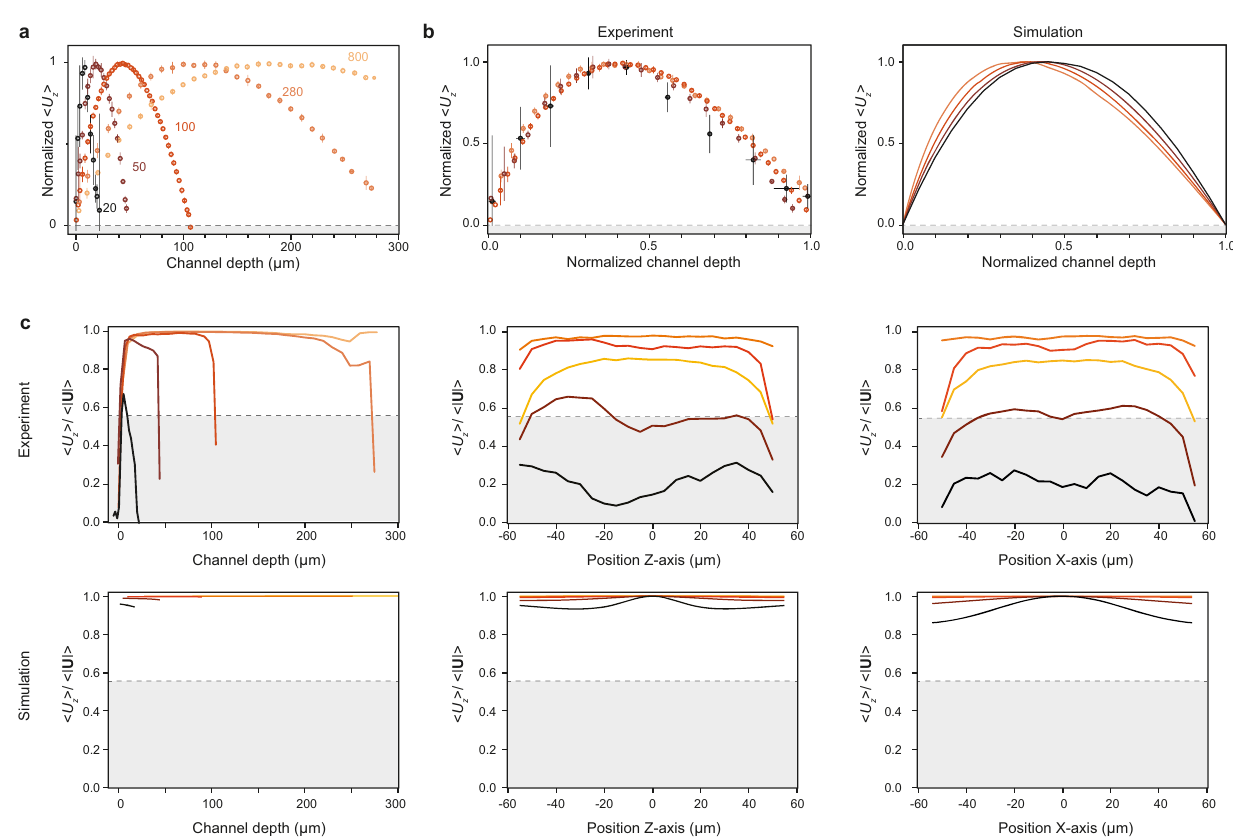
Fig. 4 Presence of convection-driven laminar fl ow in the parallel con fi guration with respect to gravity. a Normalized fl ow velocity magnitude for the average Z-component (i.e., parallel to gravity) as a function of channel depth. b Same as ( a ) but with a normalized channel depth axis, and simulations results on the right. c Empirical fi gure of merit quantifying the overall contribution of convection to the observed dynamics as a function of channel depth and position along either the x - or z -axis. The shaded area denotes the region above which the laminar fl ow term becomes dominant. Colors encode the nominal chamber height of each fl ow cell. Errors bars indicate one standard deviation from the mean of the